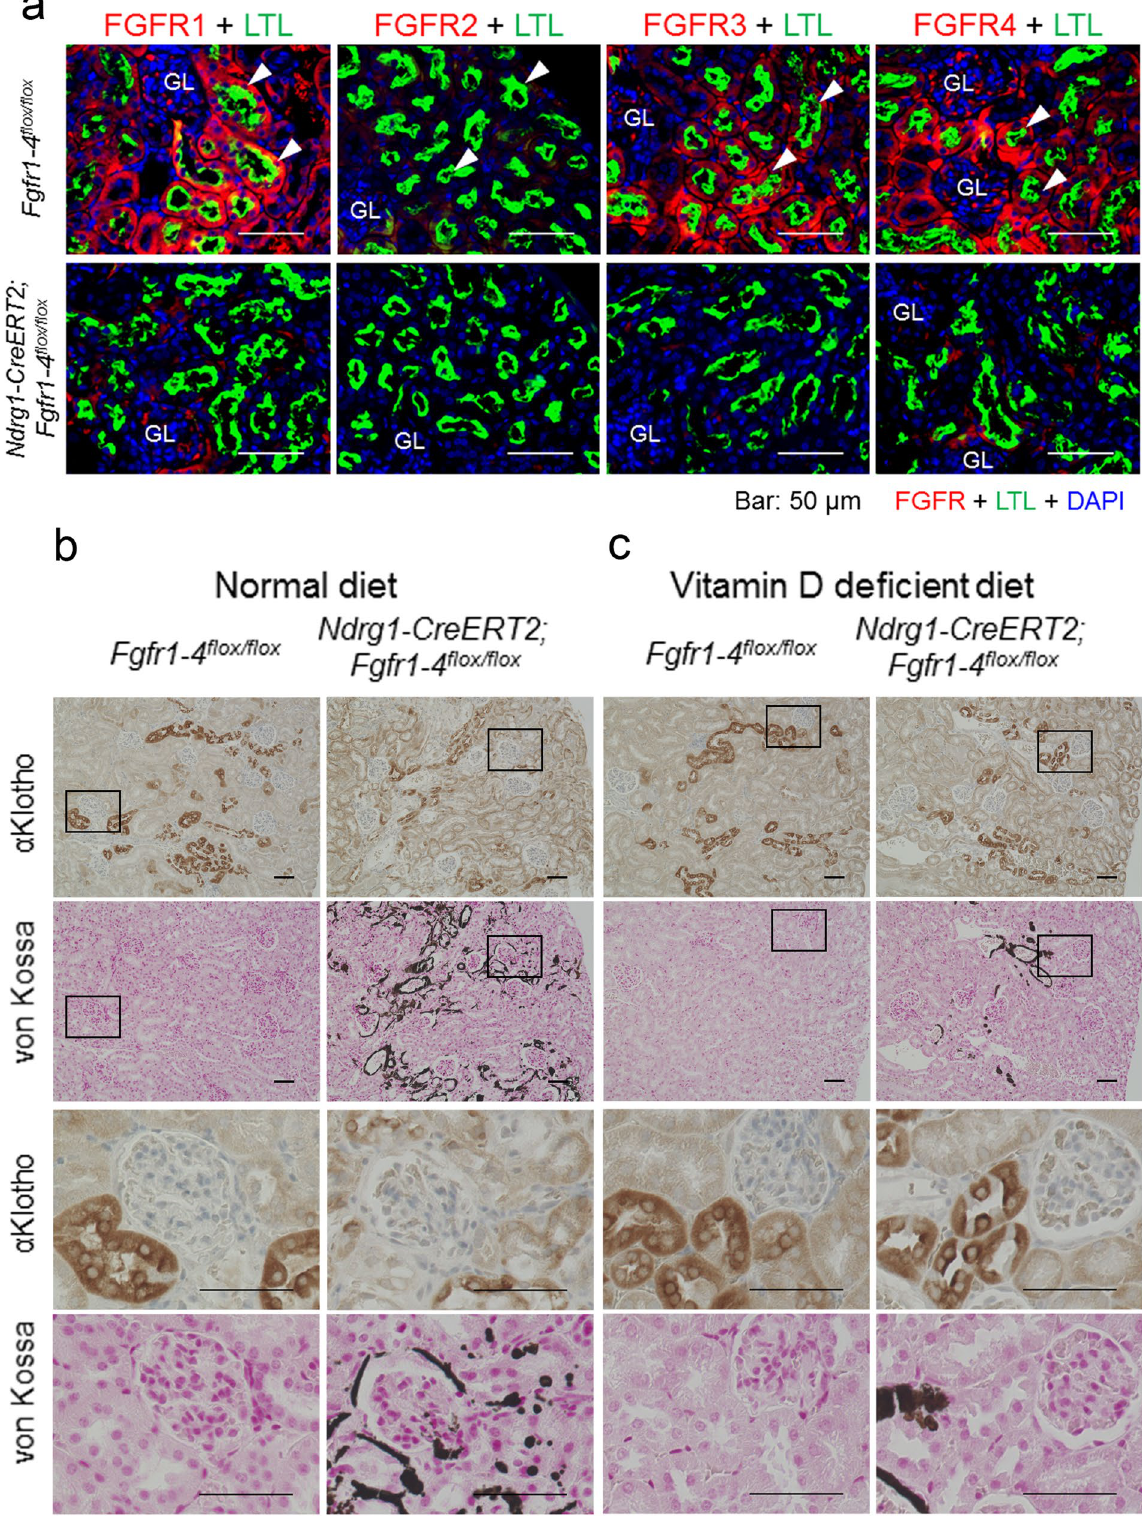
Figure 5. Proximal tubule-specific deletion of FGFR1 – 4 induces ectopic calcification and loss of α Klotho expression in distal tubules, both of which can be reversed by a vitamin D-deficient diet. ( a ) Indirect immunofluorescence staining studies for FGFR1, FGFR2, FGFR3, and FGFR4 in Fgfr1–4 flox / flox and Ndrg1- CreERT2;Fgfr1–4 flox / flox mice at 3 weeks after tamoxifen treatment. Kidney sections were immunostained for FGFR (red) with marking of proximal tubules with LTL (green) and counterstaining of cell nuclei with DAPI (blue). GL: glomerulus. Scale bars: 50 μ m. ( b ) Proximal tubular ablation of FGFRs in mice maintained on a normal diet causes cortical ectopic calcification, disassembly of distal tubular cells, and loss of distal